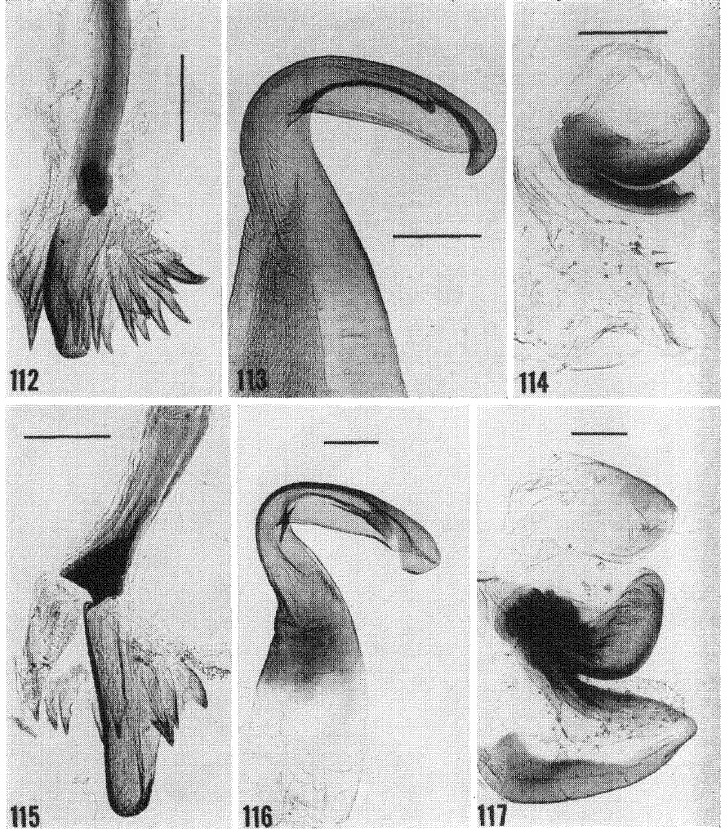
Figs. 112-117. 112-114. (177 USNM). Hyorhicnoda reflexa (Saussure and Zehntner). Turrialba, Costa Rica (det. Gurney). 115-117. Hyorh!c- noda litomorlha Hebard. Panama (det. Gurney). (scale 0.3